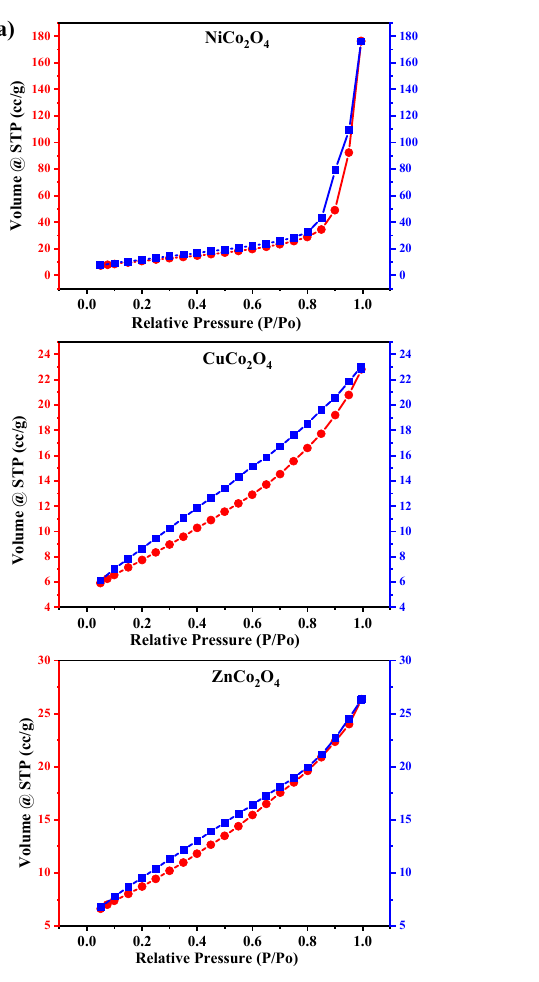
Figure 3. ( a ) N 2 adsorption-desorption isotherms for NiCo 2 O 4 , CuCo 2 O 4 , and ZnCo 2 O 4 . ( b ) Pore size distribution curves for NiCo 2 O 4 , CuCo 2 O 4 , and ZnCo 2 O 4 . Table 1. Textural properties of different spinels from N 2 - physisorption at − 196 °C.